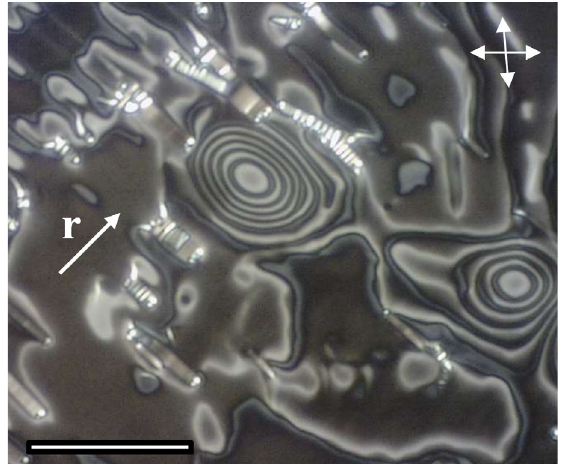
FIG. 23. Homeotropically aligned M phase after field removal X ( d ¼ 1 . 4 μ m, T ¼ 85 °C). The smectic layers are parallel to the image plane, n is perpendicular to it, and m is parallel to the layers, in the image plane. The sample is birefringent, with Δ n ∼ 0 . 02 , and the slow axis is parallel to m . In the striped areas, m rotates in the plane, and each band corresponds to a 90° rotation. (Scale bar 50 μ